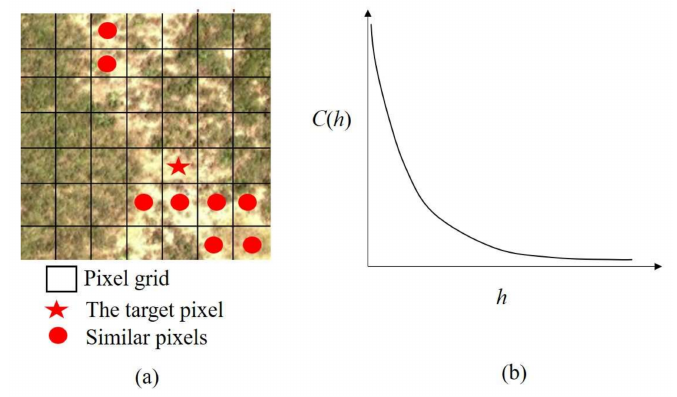
Figure 5. ( a ) Diagram of similar pixels and ( b ) shape of normal covariance